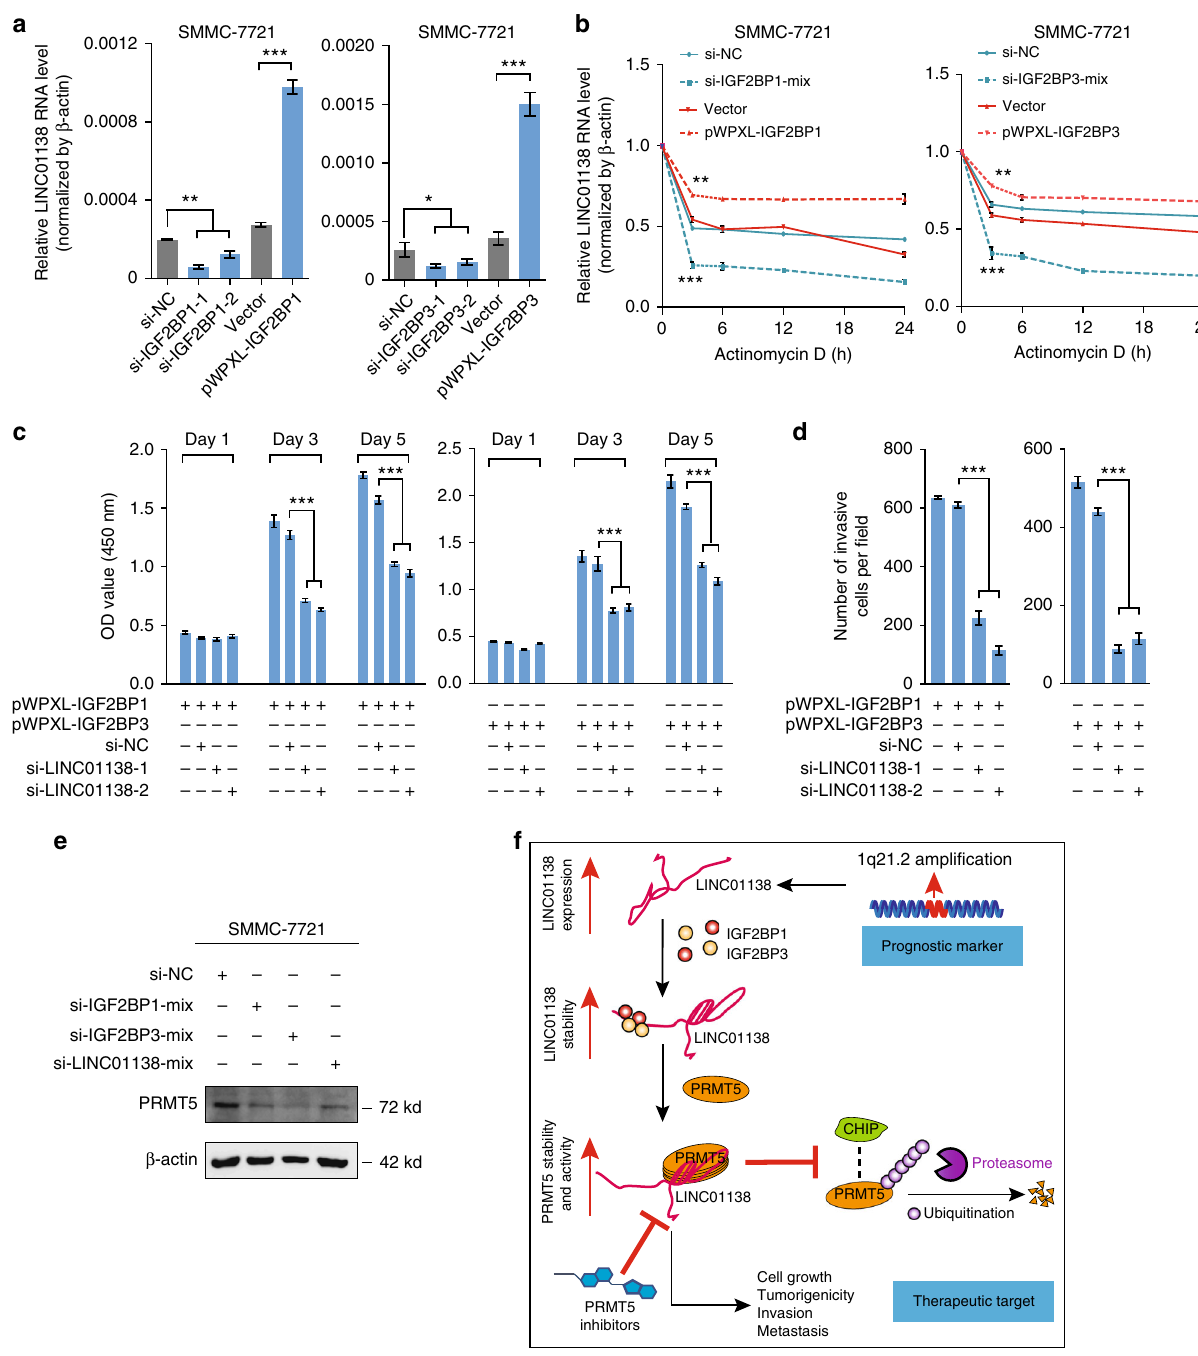
Fig. 7 The oncogenic IGF2BP1/IGF2BP3-LINC01138-PRMT5 axis in HCC cells. a Relative RNA levels of LINC01138 in SMMC-7721 cells with IGF2BP1/ IGF2BP3 knockdown or overexpression, using qPCR. b The half-life of LINC01138 after treatment with 2.5 μ M actinomycin D for indicated times, with IGF2BP1/IGF2BP3 knockdown or overexpression in SMMC-7721 cells. c CCK-8 rescue assays were performed after LINC01138 knockdown in pWPXL- IGF2BP1 or pWPXL-IGF2BP3 cells. d Transwell invasion rescue assays were performed after LINC01138 knockdown in pWPXL-IGF2BP1 or pWPXL-IGF2BP3 cells. e Immunoblotting to detect the protein levels of PRMT5 after knockdown of IGF2BP1/IGF2BP3 or LINC01138 in SMMC-7721 cells. f Integrated